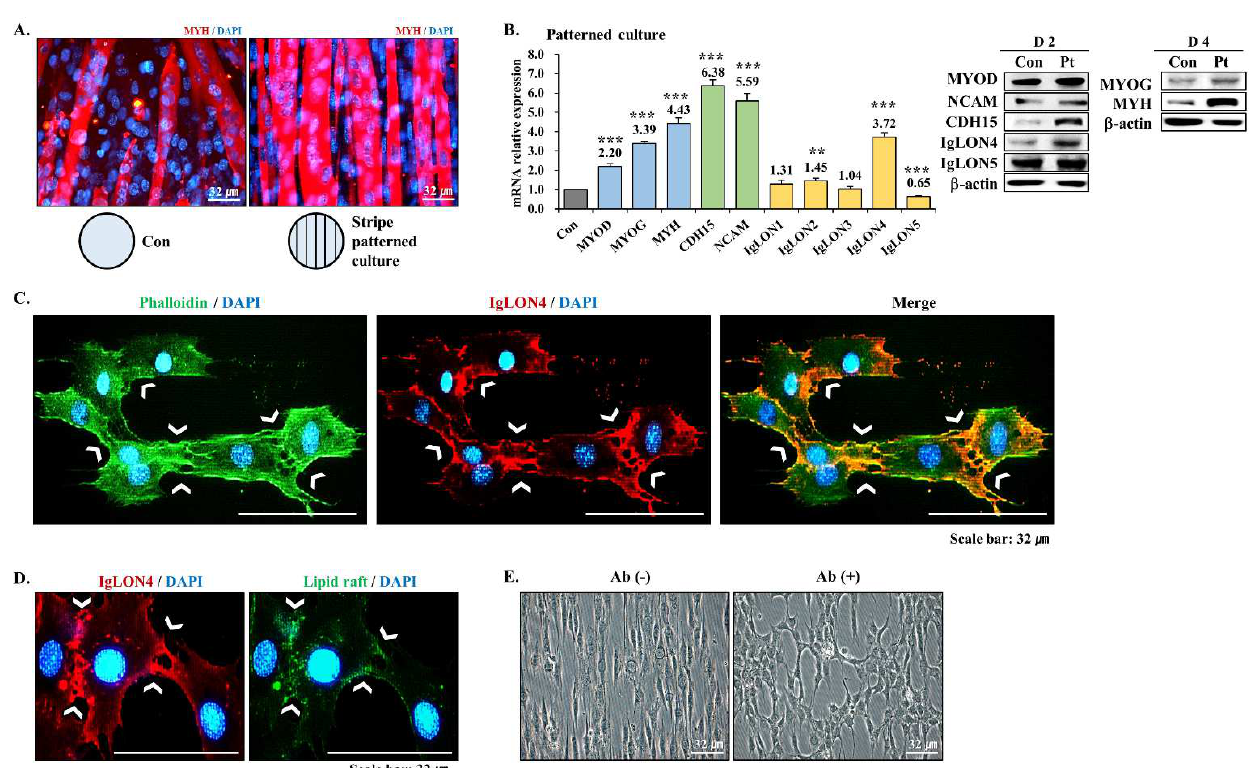
Figure 6. Effect of using striped culture plates on C2C12 myoblasts differentiation: ( A ) The formation of myotubes in normal and striped plate cultures was observed by MYH immunocytochemistry. ( B ) mRNA and protein expressions of myogenic markers, muscle-specific adhesion proteins, and IgLON family members in C2C12 myoblasts cultured in normal and striped plates on DD2 and 4 as determined by real-time RT-PCR and Western blot analysis. ( C ) Location of IgLON4 protein as determined by immunocytochemistry on DD2 in C2C12 myoblasts cultured on striped plates. Labeling was performed using fluorescently labeled phalloidin and IgLON4 (green and red, respec- tively). Phalloidin was used to counterstain cytoskeletal actin filaments. ( D ) Locations of lipid rafts and IgLON4 protein as determined by immunocytochemistry on DD2. Lipid rafts were stained us- ing labeled cholera toxin (green fluorescence) and IgLON4 with Alexa Fluor 594 (red fluorescence). ( E ) Morphologies of C2C12 myoblasts treated with or without IgLON4 antibody on DD2. Real-time PCR results were normalized to each control (con, before differentiation) and analyzed by t-test. Means ± SD (n ≥ 3). * p < 0.05, ** p < 0.01, *** p < 0.001.